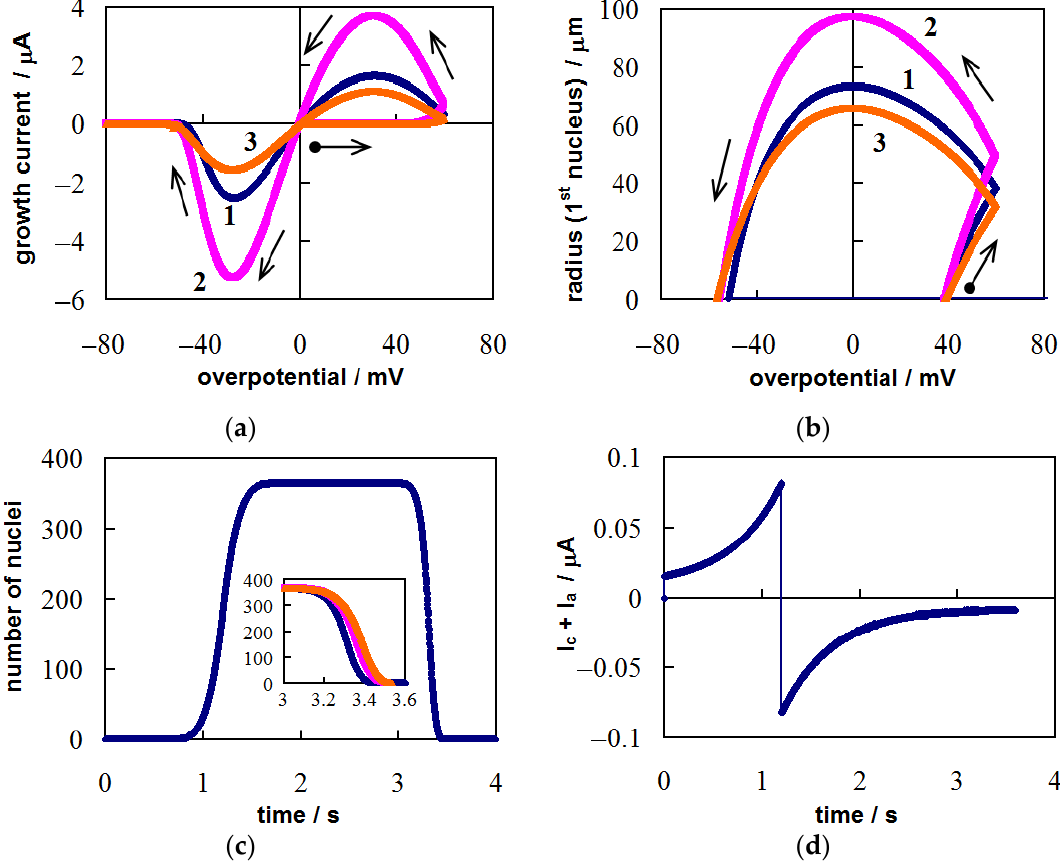
Figure 2. Calculated ( a ) CVs and ( b ) the overpotential dependences of the first nucleus radius. Calculated time dependences of ( c ) the number of nuclei and ( d ) the sum of the capacitive and adsorption currents. The dots indicate the moments of appearance of the first and last nuclei. Scan parameters: ν = 0.05 V s − 1 and η λ = 0.6 V. Values of c 0 and i 0 : c 0 = 1 × 10 19 cm − 3 , i 0 = 1 A cm − 2 (curve 1, blue); c 0 = 2 × 10 19 cm − 3 , i 0 = 1 A cm − 2 (curve 2, pink); c 0 = 1 × 10 19 cm − 3 , i 0 = 0.6 A cm − 2 (curve 3, orange). Other parameters are indicated in the text.